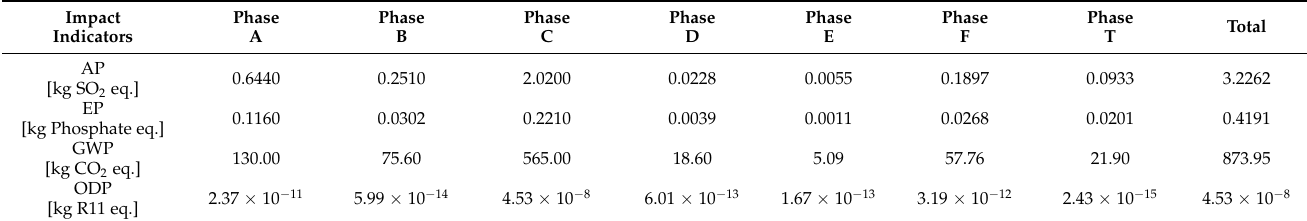
Table 11. Impact assessment as per phases.